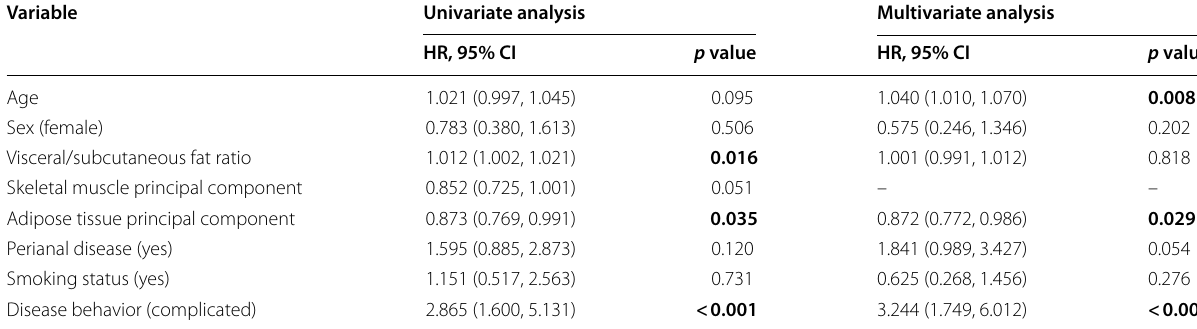
CD Crohn’s disease, HR hazard ratio, CI confidence interval; visceral/subcutaneous fat ratio, area of visceral fat/area of subcutaneous fat, p values lower than 0.05 are presented in bold